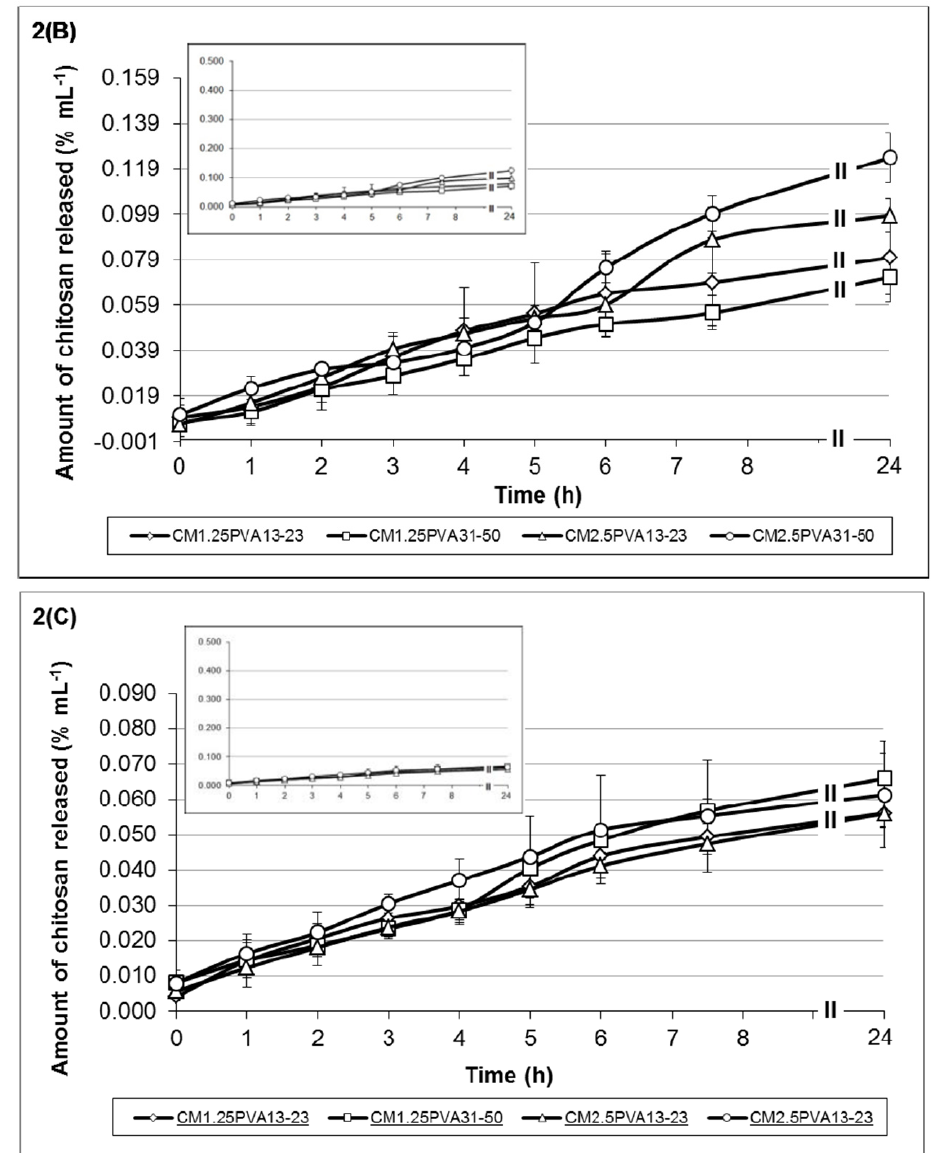
Figure 2. Cumulative release of ( A ) low ‐ viscosity chitosan; and ( B ) medium ‐ viscosity chitosan from hydrogel formulations containing TTO: 10 w / v PVA (35:65 v / v ratio); and ( C ) medium ‐ viscosity chitosan from hydrogel formulations containing TTO: 10 w / v PVA (50:50 v / v ratio). A sub ‐ graph has been provided in both ( B , C ) to provide an overview of the amount of released chitosan in comparison to (2 A ). The codes shown in the figure key describe the following: C L1.25 = 1.25% w / v low ‐ viscosity chitosan, C L2.5 = 2.5% w / v low ‐ viscosity chitosan, C M1.25 = 1.25% w / v medium ‐ viscosity chitosan, C M2.5 = 2.5% w / v medium ‐ viscosity chitosan, PVA 13 ‐ 23 = PVA 13–23 kDa, PVA 31 ‐ 50 = PVA 31–50 kDa. The error bars represents the standard deviation and n = 3.